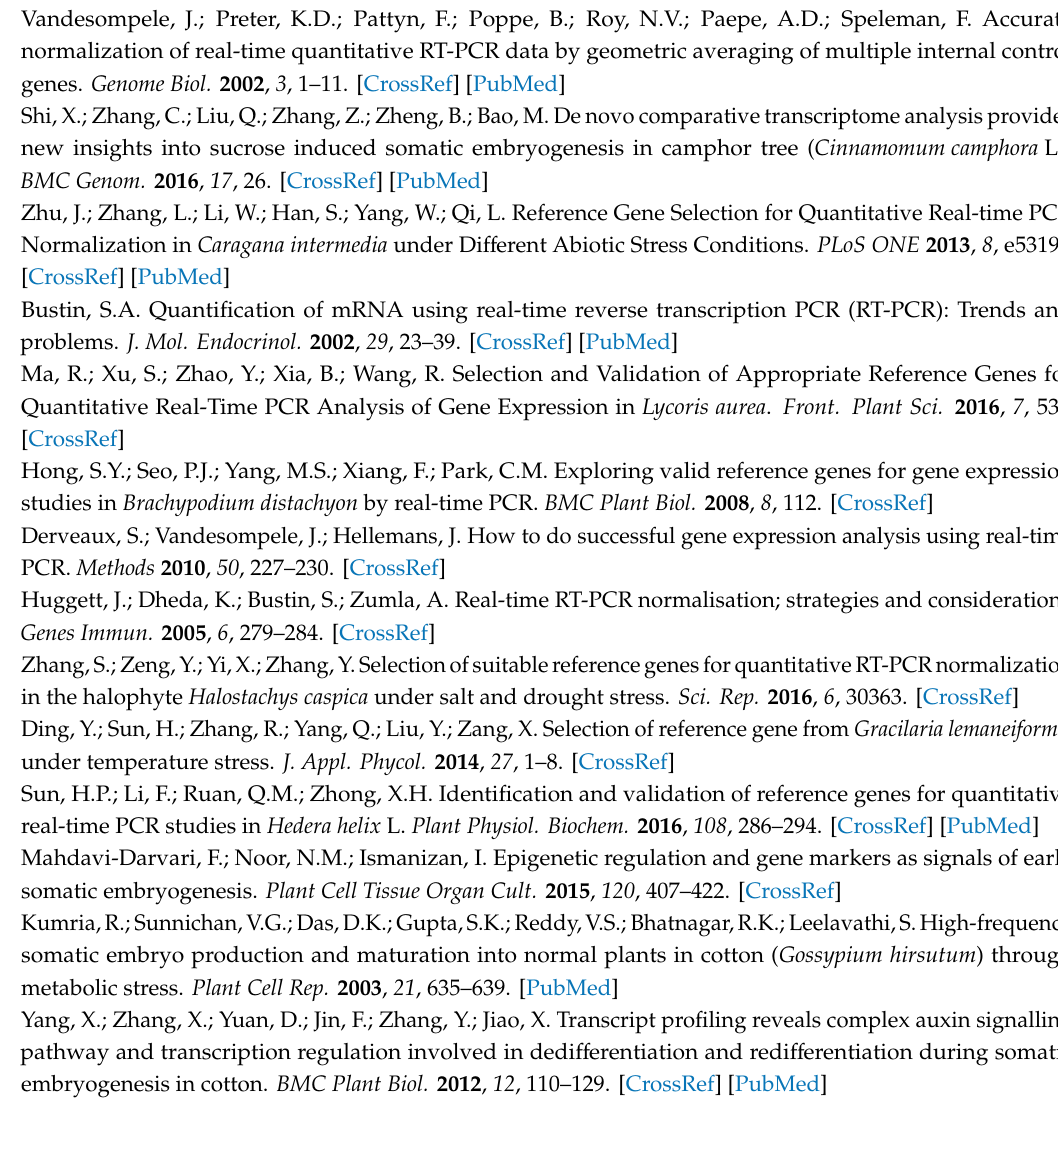
Figure S1: Melting curves of the 15 selected reference genes, Table S1: Cq value of the 15 candidate reference genes, Table S2: The details of the 15 candidate reference genes based on RNA-Seq